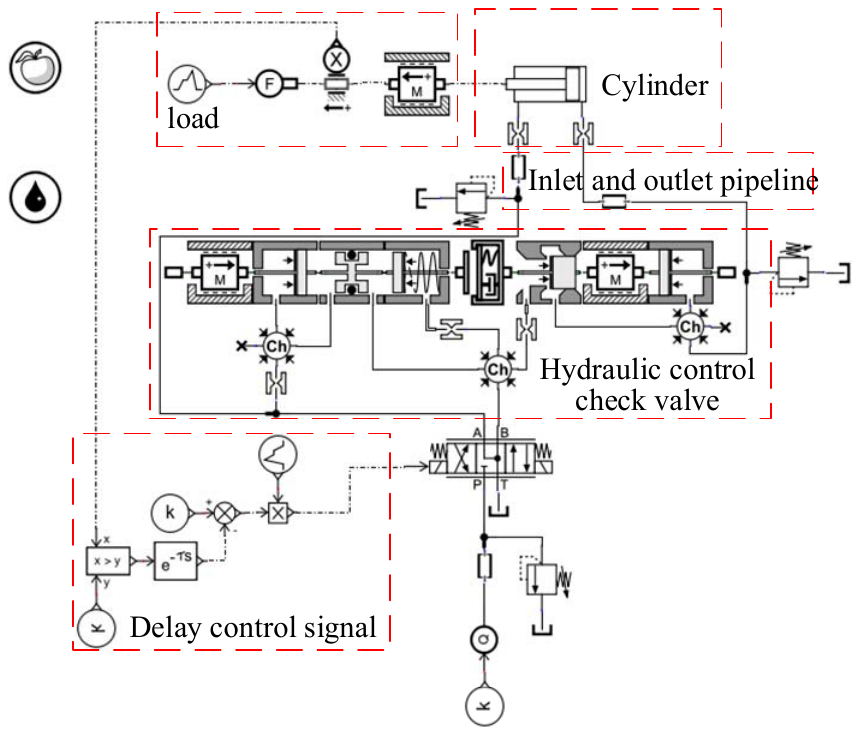
Figure 2. Hydraulic schematic diagram of advancing control circuit. Table 1. AMESim simulation parameters of the hydraulic system of control circuit advancing.